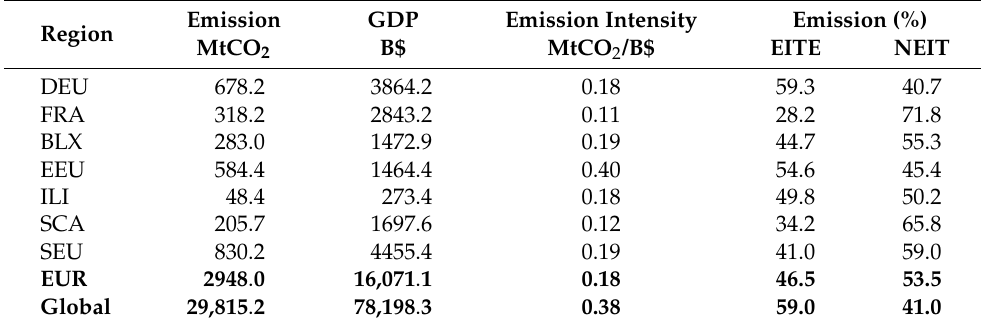
Table 3. CO 2 emission, GDP, emission intensity, and percentage of emission by EITE and NEIT sectors for the selected model regions in the benchmark in 2014. Emission Region